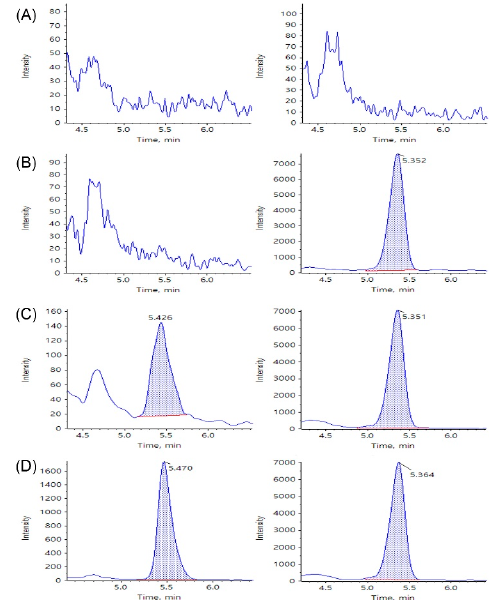
Figure 3. Selected reaction monitoring (SRM) LC-MS/MS chromatograms of sirolimus ( left ) and IS ( right ) obtained by deproteinization of ( A ) blank porcine lung tissue, ( B ) blank porcine lung tissue spiked with 1 ng/mL of IS, ( C ) blank porcine lung tissue spiked with sirolimus at LLOQ 0.5 ng/mL and 1 ng/mL of IS, and ( D ) a porcine lung sample at 1 h in the pharmacokinetic studies.